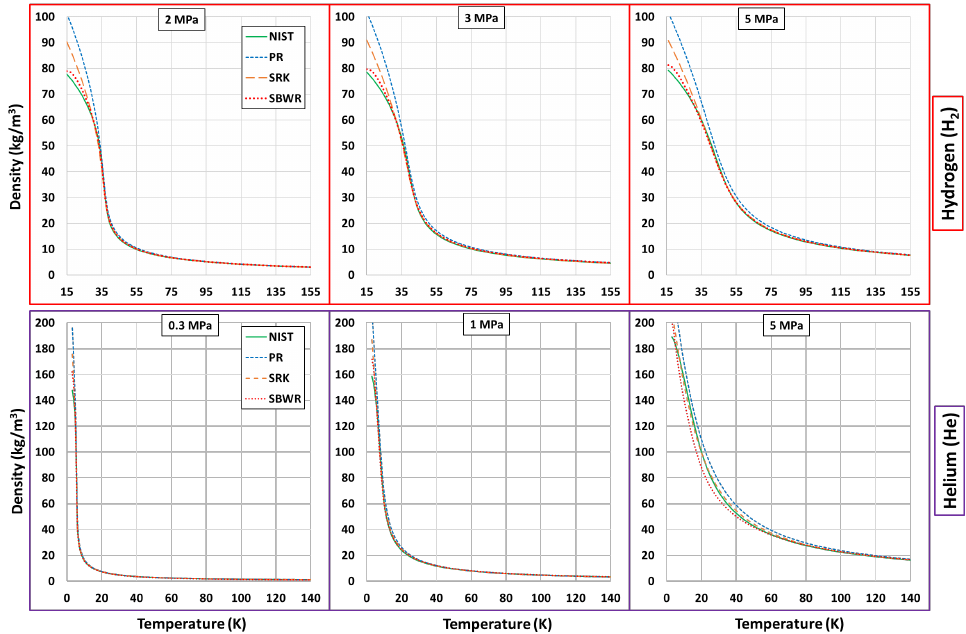
Figure A1. Plots of estimated density using PR, SRK and SBWR EoS compared with NIST for two cryogenic fluids-H 2 and He, at three supercritical pressures.